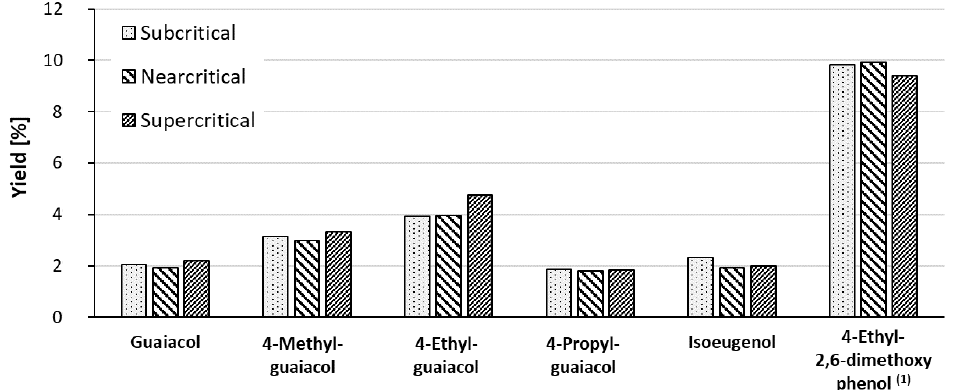
Figure 5. Mononuclear products observed for catalytic hydrogenolysis of kraft lignin in methanol with Pt/C at subcritical (200 °C, 76 bar, left ), near-critical (235 °C, 110 bar, middle ), and supercritical (250 °C, 131 bar, right ) conditions; (1) 4-ethyl-2,6-dimethoxyphenol or